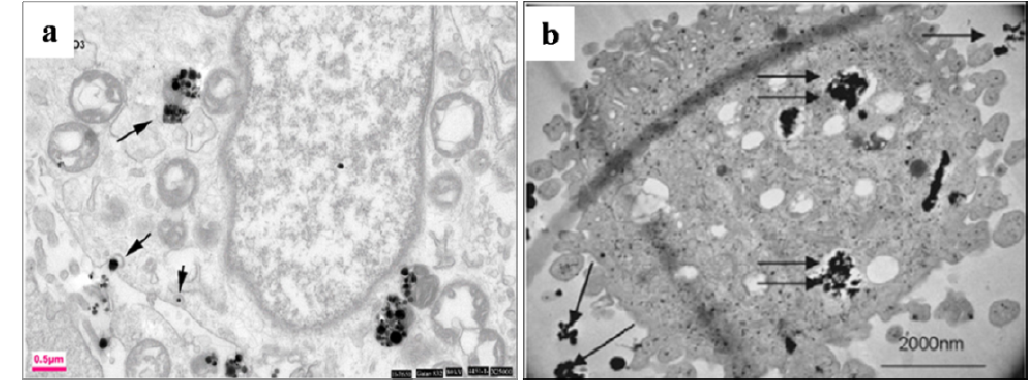
Arrows pointing to the process of internalization at the surface associated with actin rearrangement near the plasma membrane and extension into the extracellular space [150] and ( b ) SEM image of live primary human dermal fibroblasts exposed to CoCr alloy nanoparticles for 24 h outside and inside the cell [139].